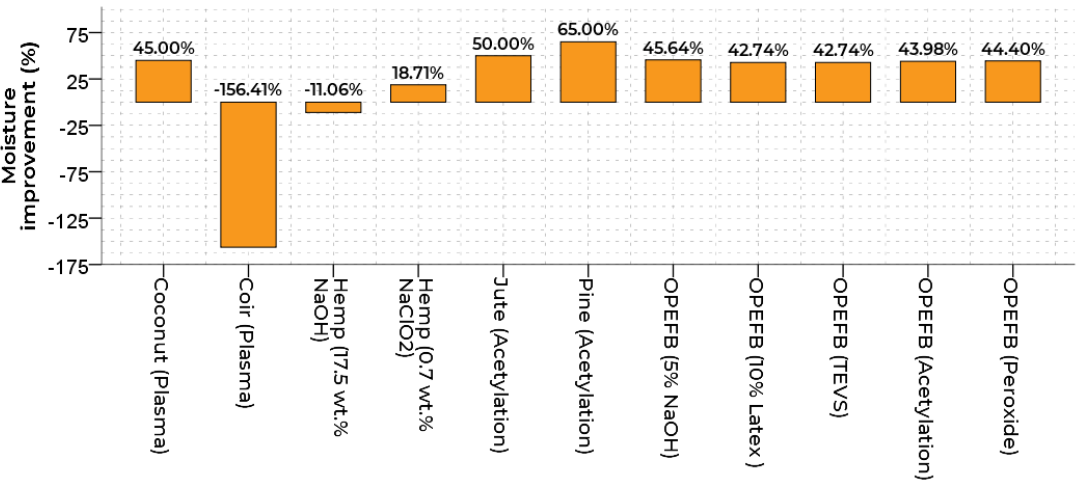
Figure 7. The improvement percentage of different treatments on moisture absorption behavior of natural fibers. Coconut plasma [147], coir (plasma) [183], hemp (17.5 wt. % NaOH) [184], hemp (0.7 wt. % NaClO 2 ) [184], jute (acetylation) [96], pine (acetylation) [96], OPEFB (5% NaOH) [70], OPEFB